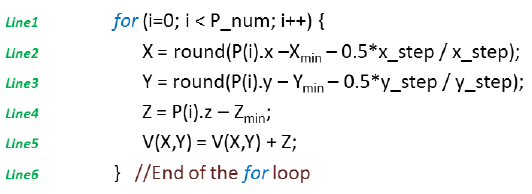
Figure 2: Pseudocode of generating the 2D probability matrix